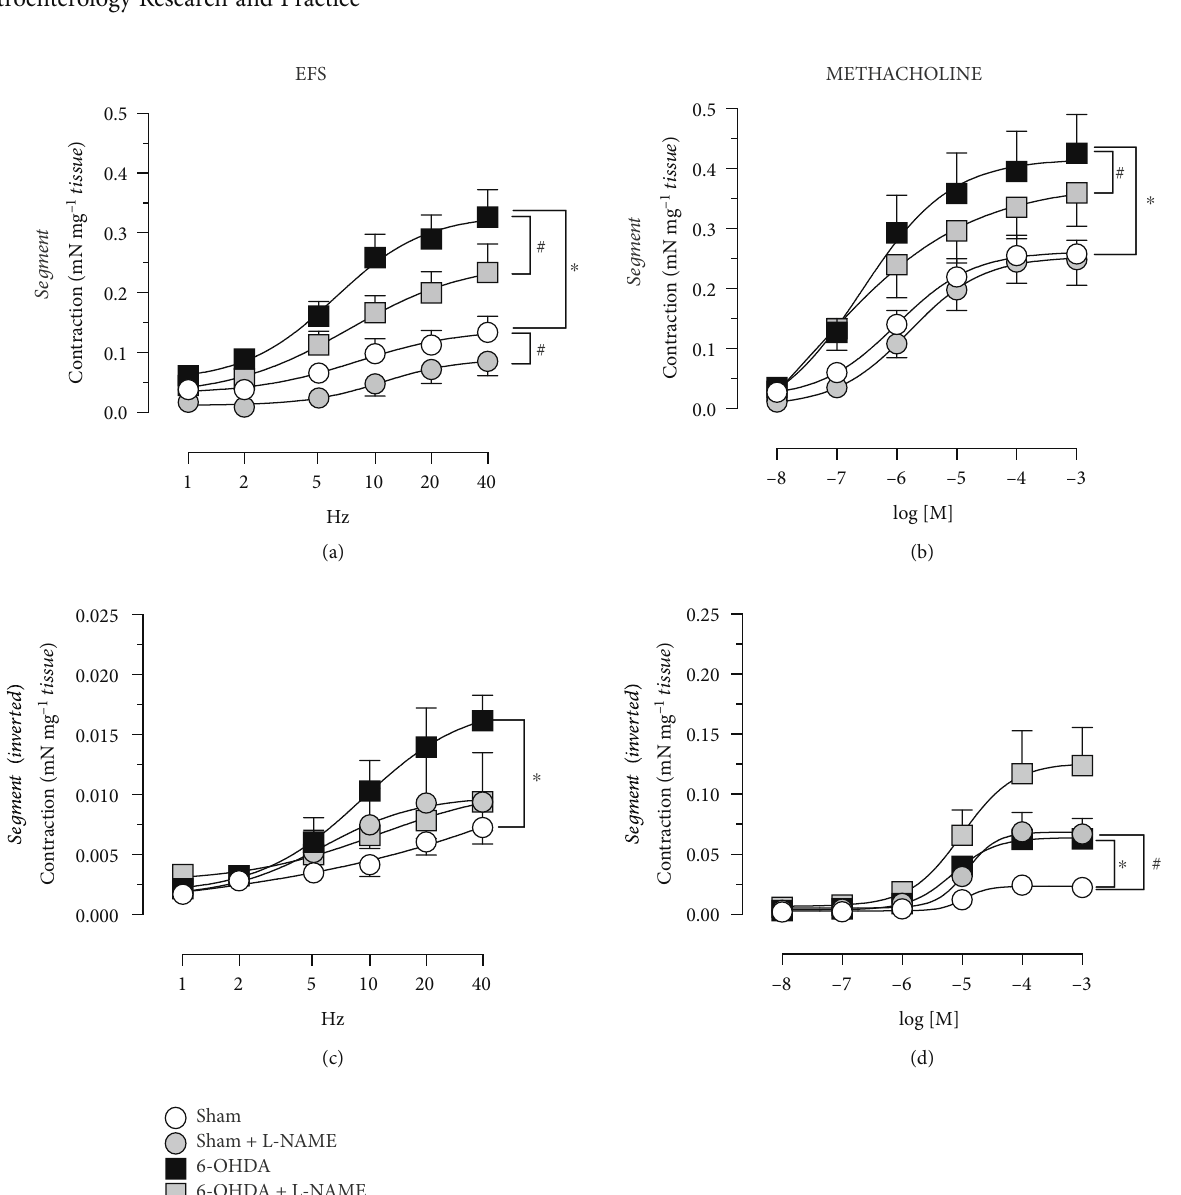
Figure 3: Contractions of distal colon segments and inverted segments following electrical fi eld stimulation (EFS) and methacholine in the absence and presence of the nitric oxide synthase inhibitor L-NAME. Signi fi cant and similar reduced contractile responses in EFS by L- NAME were observed in the segments in both Sham ( n = 6 ) and 6-OHDA animals ( n = 5 ; a). However, L-NAME reduced the methacholine-mediated contractility in the 6-OHDA animals ( n = 6 ), but not in the Sham group ( n = 5 ; b). The inverted segments showed signi fi cant increased responses to EFS (c) and methacholine (d) in the 6-OHDA ( n = 4 ) as compared with Sham group ( n = 6 ) in the absence of L-NAME. In the presence of L-NAME the EFS response showed no di ff erence within respective groups, but a trend to decrease could be seen in the 6-OHDA animals. The methacholine response on the other side was signi fi cantly increased in the Sham group after L-NAME. The increase was however, not signi fi cant in the 6-OHDA animals. *Signi fi cant di ff erence from Sham group; #=signi fi cant di ff erence between presence and absence of L-NAME in respective group. Two-way ANOVAs (a) *=group F ð 1, 9 Þ = 15 : 31, p = 0 : 00036 ; and #=group F ð 1, 5 Þ = 14 : 29 , p = 0 : 0129 ; F ð 1, 4 Þ = 8 : 44 , p = 0 : 0438 for Sham and 6-OHDA, respectively; (b) *=group F ð 1, 9 Þ = 6 : 36 , p = 0 : 0327 and #=group F ð 1, 4 Þ = 7 : 84, p = 0 : 0488 for 6-OHDA; (c): *=group F ð 1, 8 Þ = 6 : 80 , p = 0 : 0312 ; (d) *=group F ð 1, 8 Þ = 38 : 32 ,